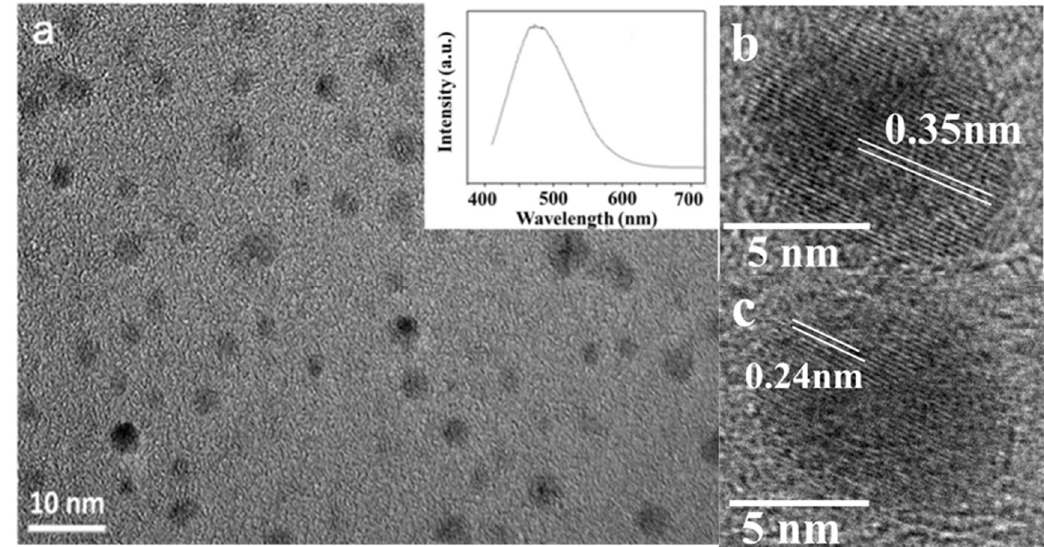
Figure 1. ( a ) TEM images of graphene quantum dots (GQDs) and the photoluminescence (PL) spectrum of GQDs excited at a wavelength of 400 nm (inset); ( b ) and ( c ) High-resolution transmission electron microscopy (HRTEM) images of GQDs.